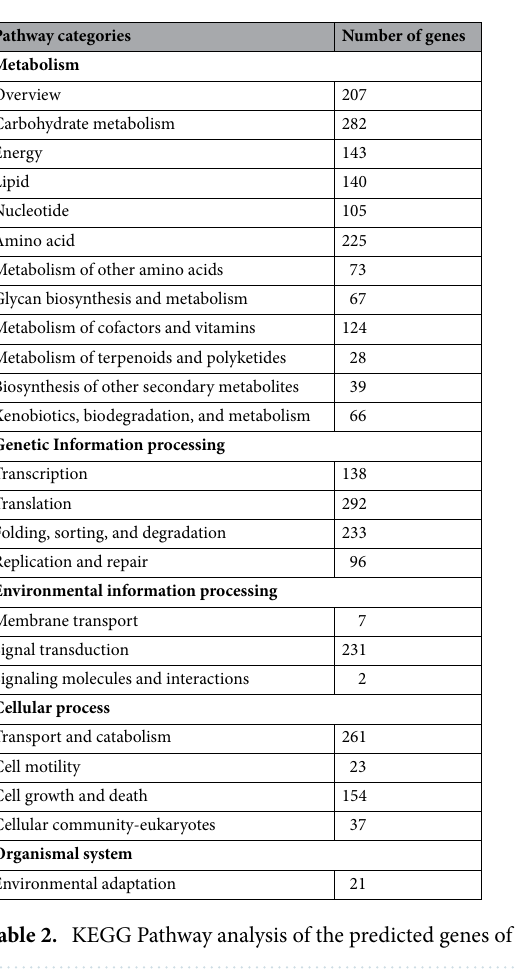
processes, and 4151 genes were assigned to cellular functions (Fig. 2b). Further, the potential involvement of the 2994 predicted genes in different KEGG pathways was established (Table 2). All the genes were classified mainly